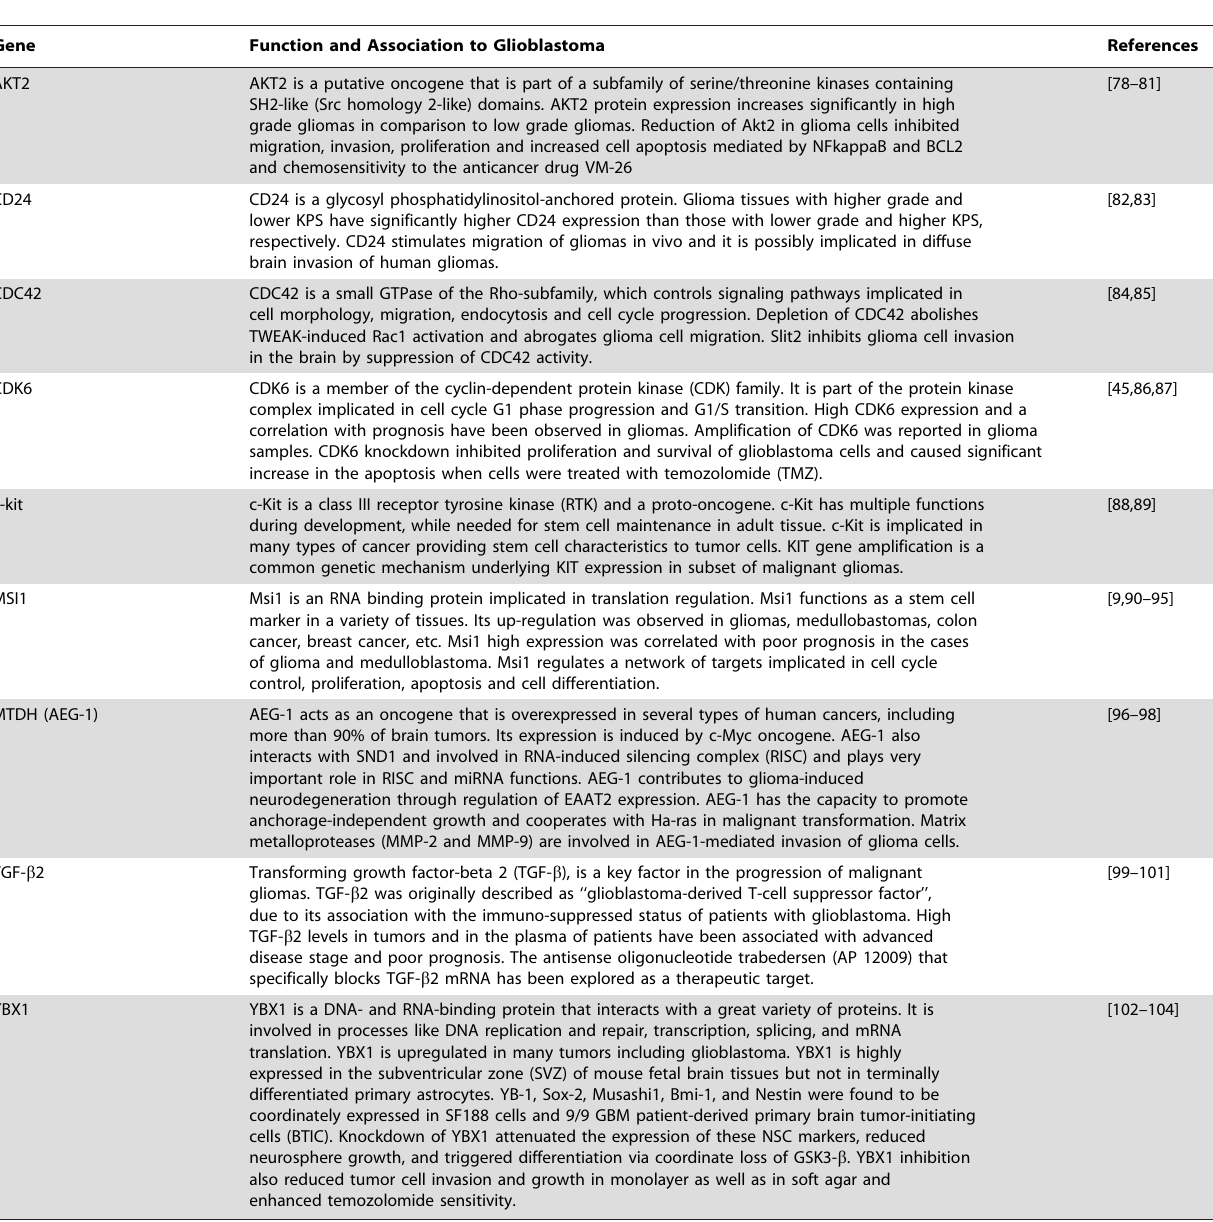
Table 1. Most relevant oncogenes affected by miR-137 transfection with previously described function in gliomagenesis.